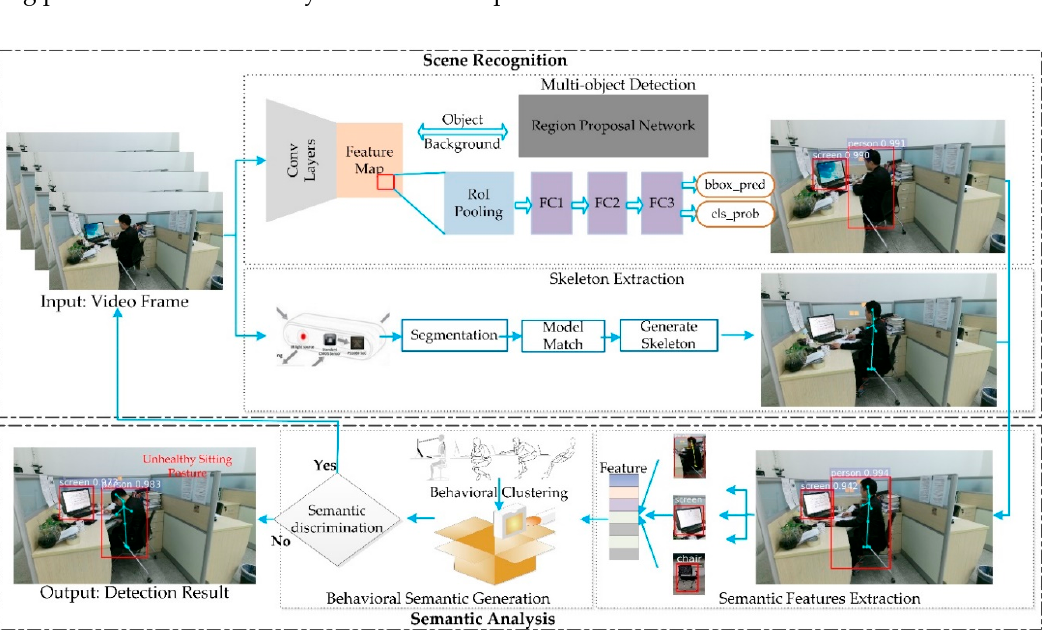
Figure 1. Framework of our proposed method for sitting posture detection. The framework is divided into two parts, i.e., the scene recognition and the semantic analysis.